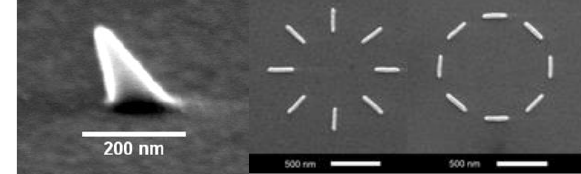
Fig. 1. Tilted gold nanocone (left), radial oligomer (center) and azimuthal oligomer (right) that are imaged by SHG imaging microscopy with cylindrical vector beams.